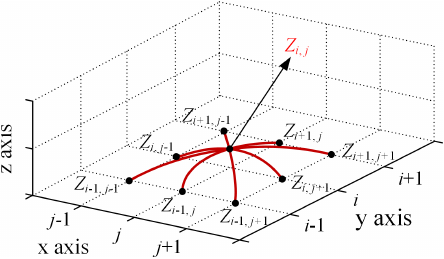
Figure 4. Modified nine-point rectangular definition of rough as- perity in the independent